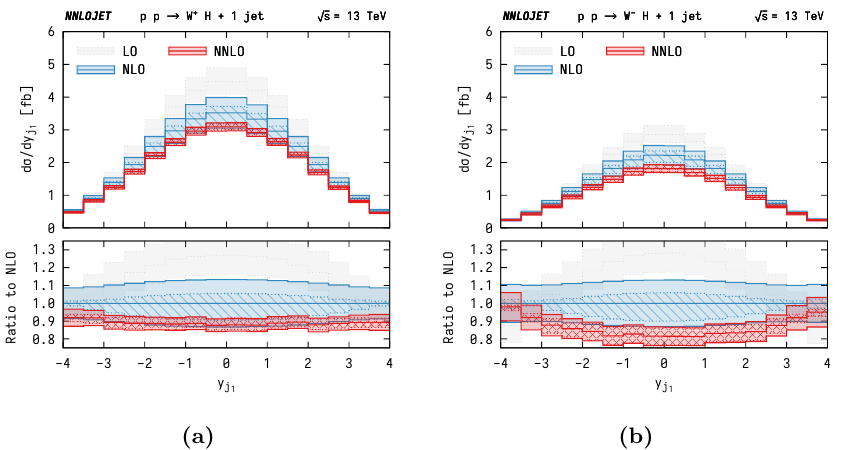
Figure 7. The rapidity distribution of the jet produced in exclusive WH + jet production for (a) W + (b) W −